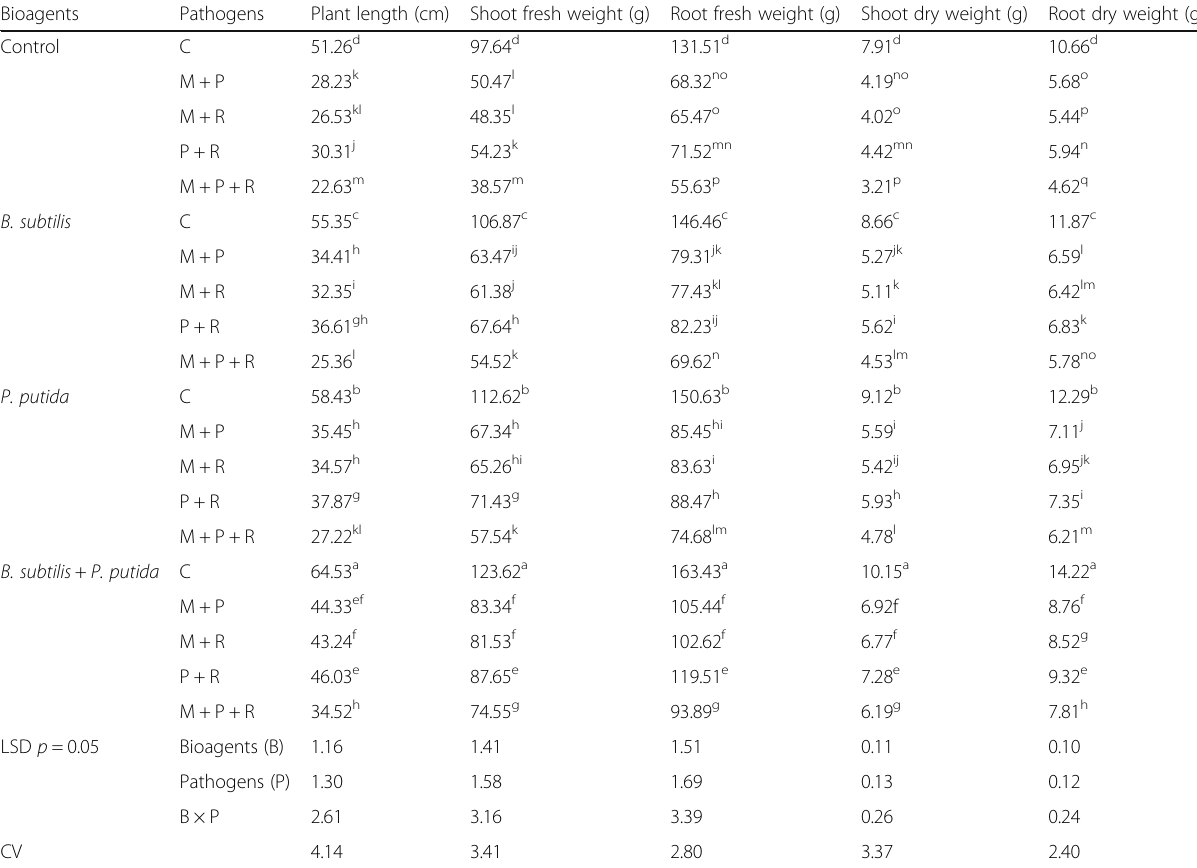
Table 4 Influence of Pseudomonas putida , Bacillus subtilis , and their mixtures on the plant length, shoot fresh weight, root fresh weight, shoot dry weight, and root dry weight of beetroot infected with two/three pathogens simultaneously in a disease